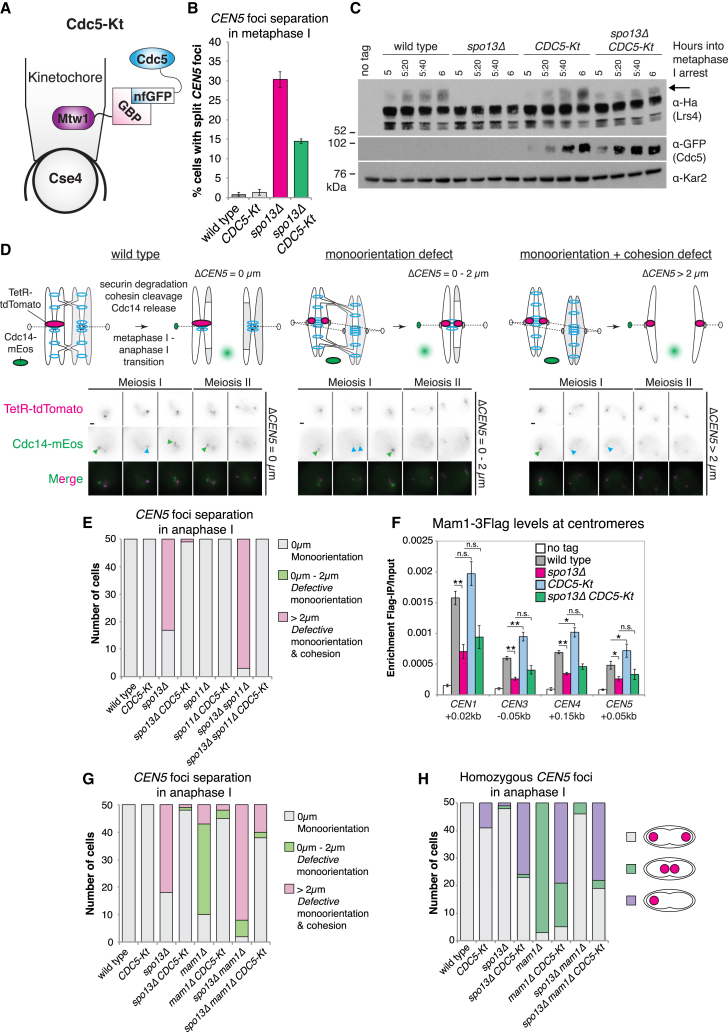
Cdc5-Kt Restores Sister Chromatid Co-segregation to Monoorientation Mutants(A) Schematic representation of Cdc5-Kt.(B) Mean number of metaphase-I-arrested cells with two distinct tdTomato foci from three experimental replicates with standard error bars (n = 200).(C) Immunoblot analysis of Lrs4-6Ha, Cdc5-GFP, and Kar2 loading control. Arrow indicates hyperphosphorylated Lrs4-6Ha.(D) Assay for monoorientation and cohesion defects with representative images below. Scale bars, 1 μm. Green arrows, nucleolar Cdc14; Cyan arrows, Cdc14 at SPBs in anaphase I.(E) Frequency of heterozygous CEN5 distance categories from (D) after live-cell imaging. Maximum distance between two TetR-tdTomato foci within two time points after initial Cdc14 release was measured (n = 50).(F) Mean enrichment of Mam1-3Flag in metaphase I from six experimental replicates, with standard error bars (∗p < 0.05, ∗∗p < 0.01).(G) CEN5 distance categories determined as in Figure 2E.(H) Frequency of homozygous CEN5-tdTomato foci segregating (gray), co-segregating (purple), or failing to segregate (green) within two time points after the first round of Cdc14 release (n = 50).See also Figure S2.